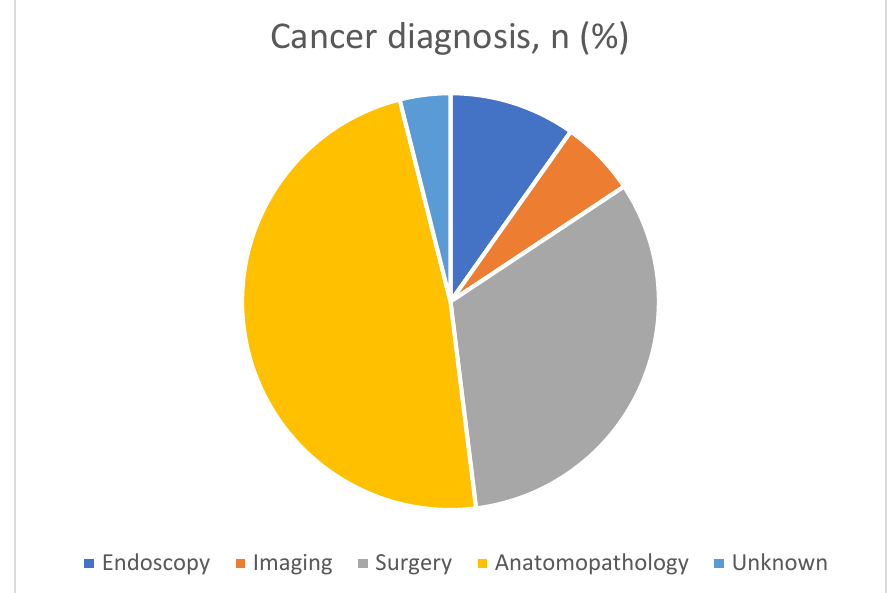
Figure 1. Cancer diagnosis in our study.